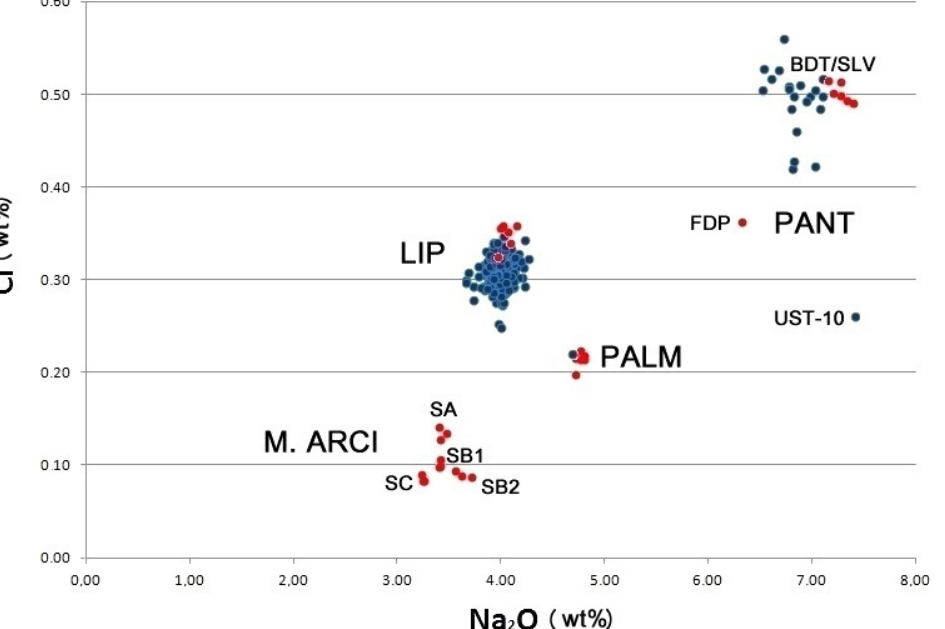
Figure 6 : Correlations between chlorine and the main network modifying cations (Na, K, Mg, Ca), total alkali (Na index (PI), in the geological obsidian data set of this study.